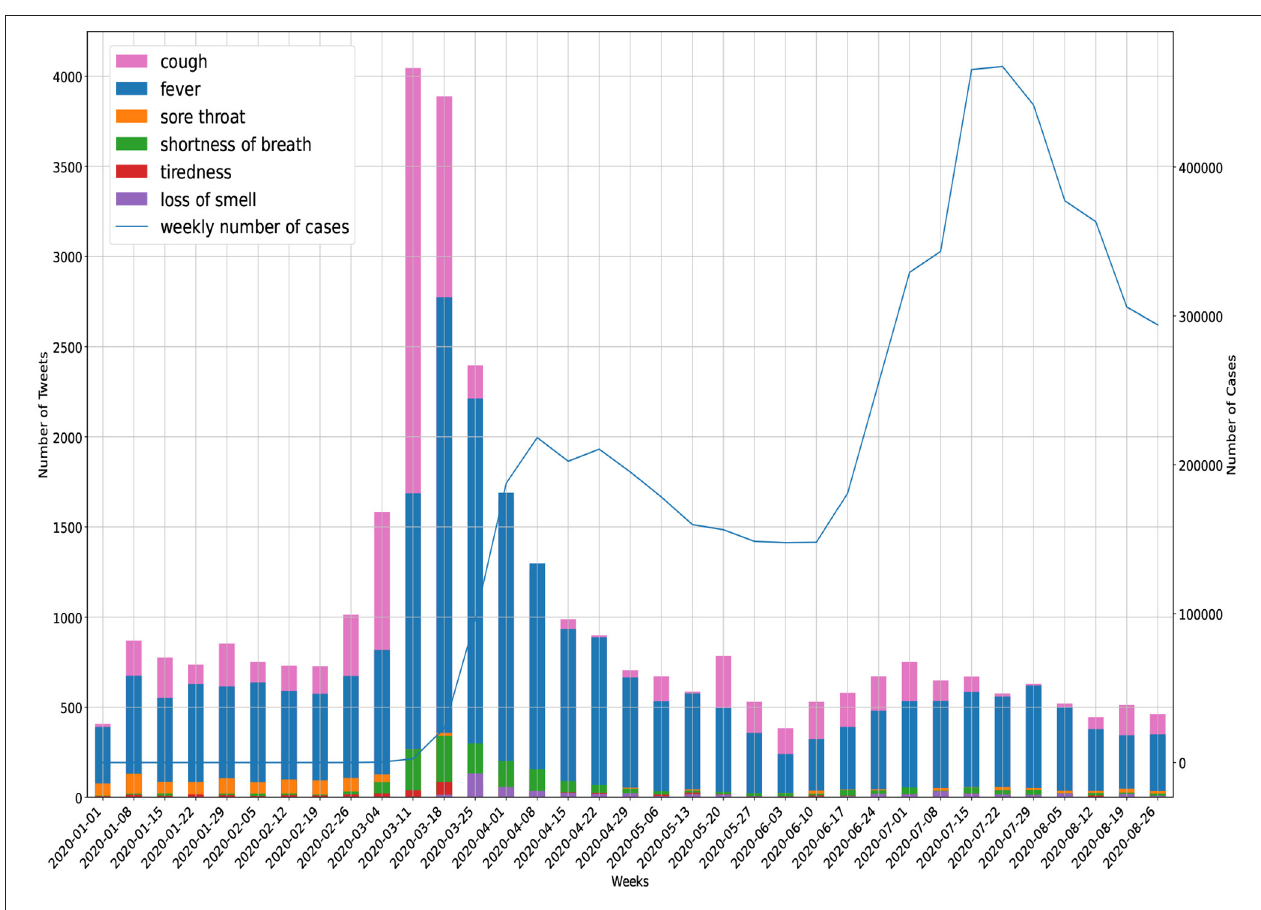
FIGURE 5 | Symptom reporting in Twitter (United States).